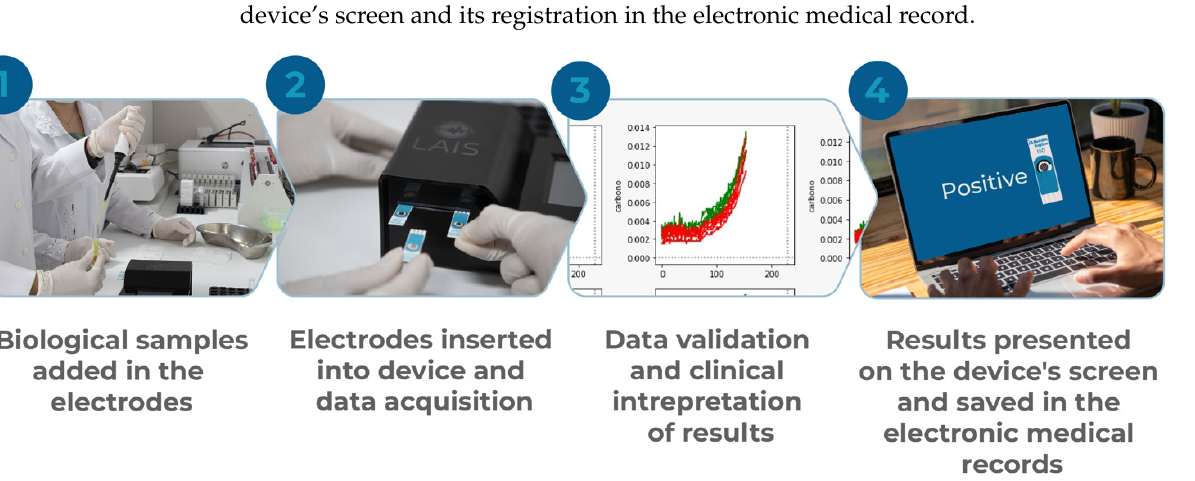
Figure 4. Graphic summary of the procedure from the input of biological samples to the data processing and presentation of results on the device’s screen and its registration in the electronic medical record.